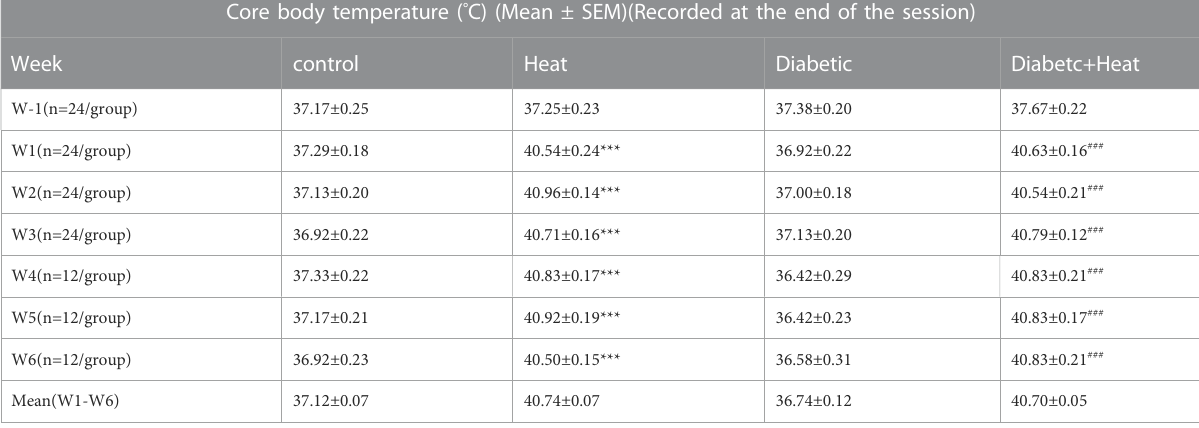
TABLE 2 Core body temperature ( ° C) (Mean ± SEM) measured at the end of the session. Core body temperature ( ° C) (Mean ± SEM)(Recorded at the end of the